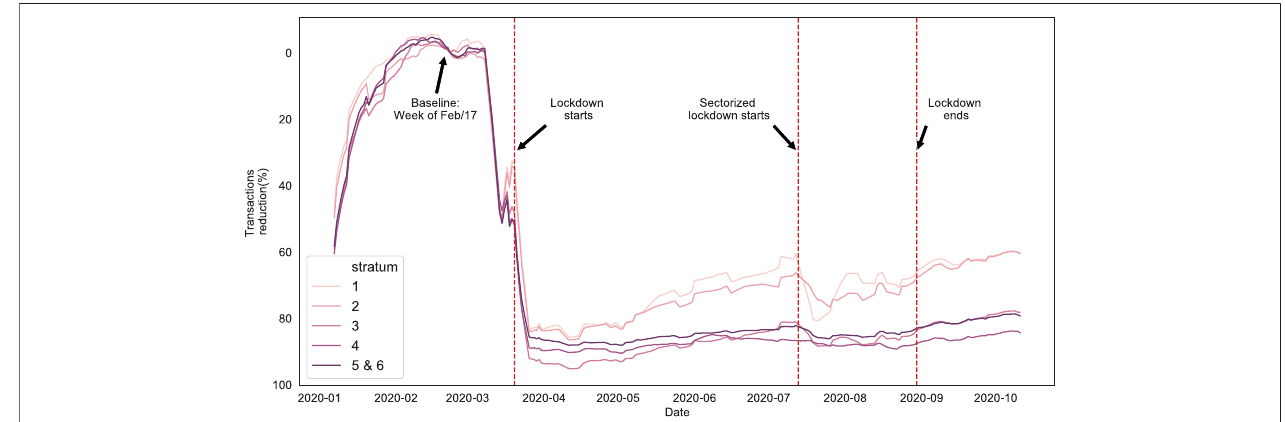
FIGURE 5 | 7-days rolling average reduction of transactions (%) by strata. Reference is the week of February 17, 2020. Red dotted lines mark the start of the lockdown (Mar/20), the sectorized lockdown (Jul/13) and the end of the lockdown (Sep/01).